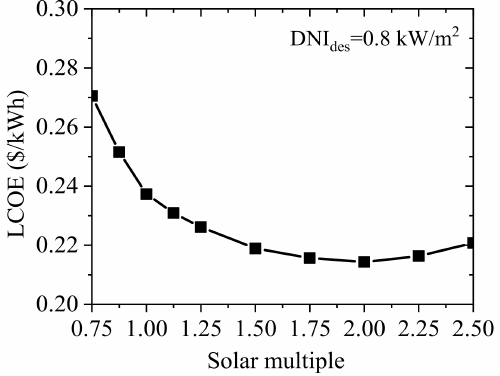
Figure 10. LCOE for every solar